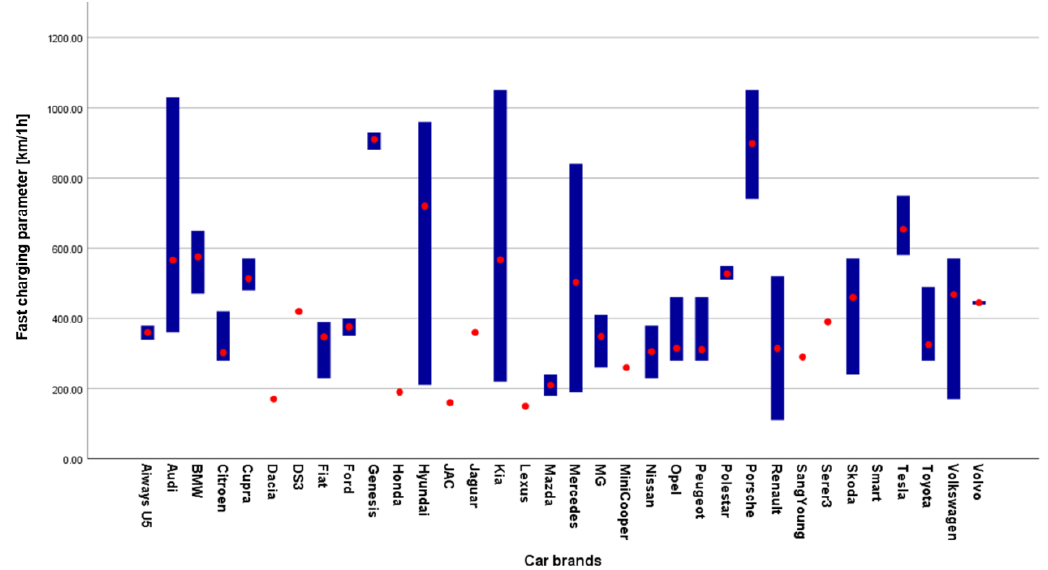
Figure 13. Range bar variation (min, max, mean) representation of fast charging speed vs. brands of cars.